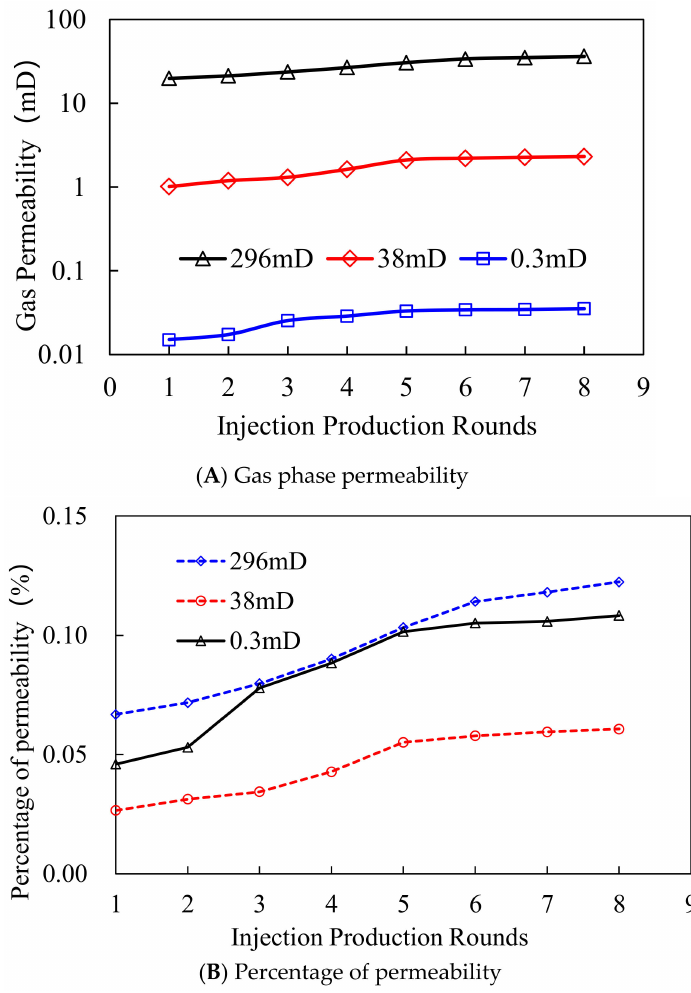
Figure 7. Effect of multi cycle gas injection on permeability change of cores with different